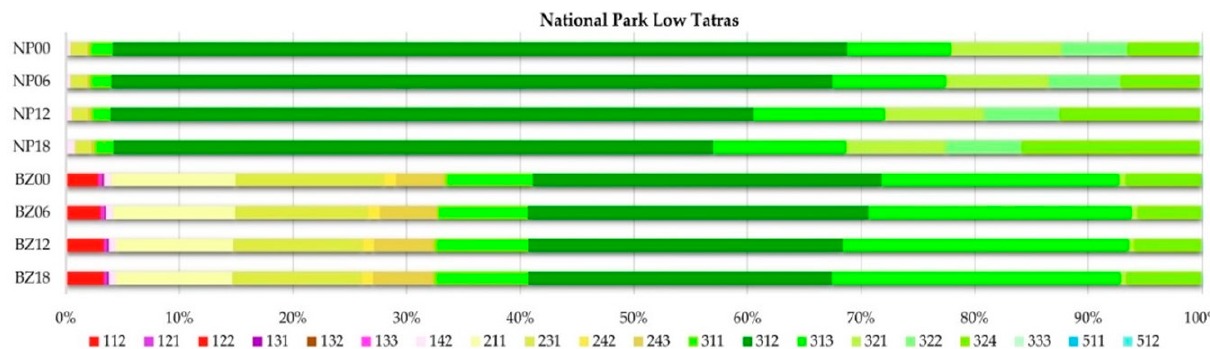
Figure 2. Development of Land Cover/LC values for TANAP and NAPALT according to recorded CLC3 data in 2000, 2006, 2012, 2018. NP—national park area, BZ—buffer zone. Description of the land cover classes (codes) in the legend is available at the following link: https://land.copernicus.eu/pan-european/corine-land-cover (accessed on 10 March 2019). Table 3. Development of CLC-changes in TANAP (in the national park and its buffer zone separately). Tatra National CLC3-Change